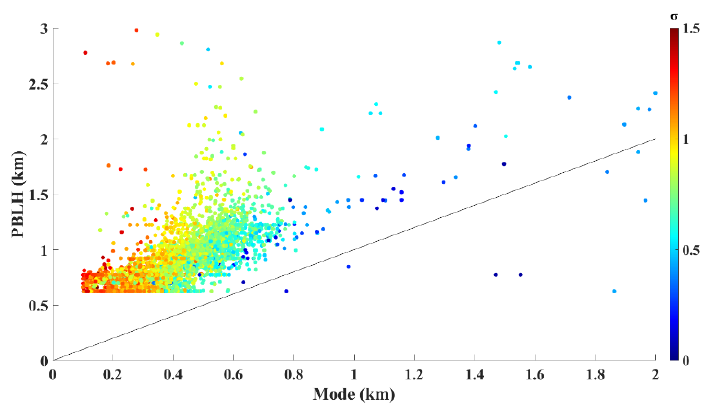
Figure 4. Scatter plot of the PBLH and the Mode. The logarithmic standard deviation ( σ ) values are denoted by the color scale. The solid black line indicates the equivalent line between the PBLH and the Mode.